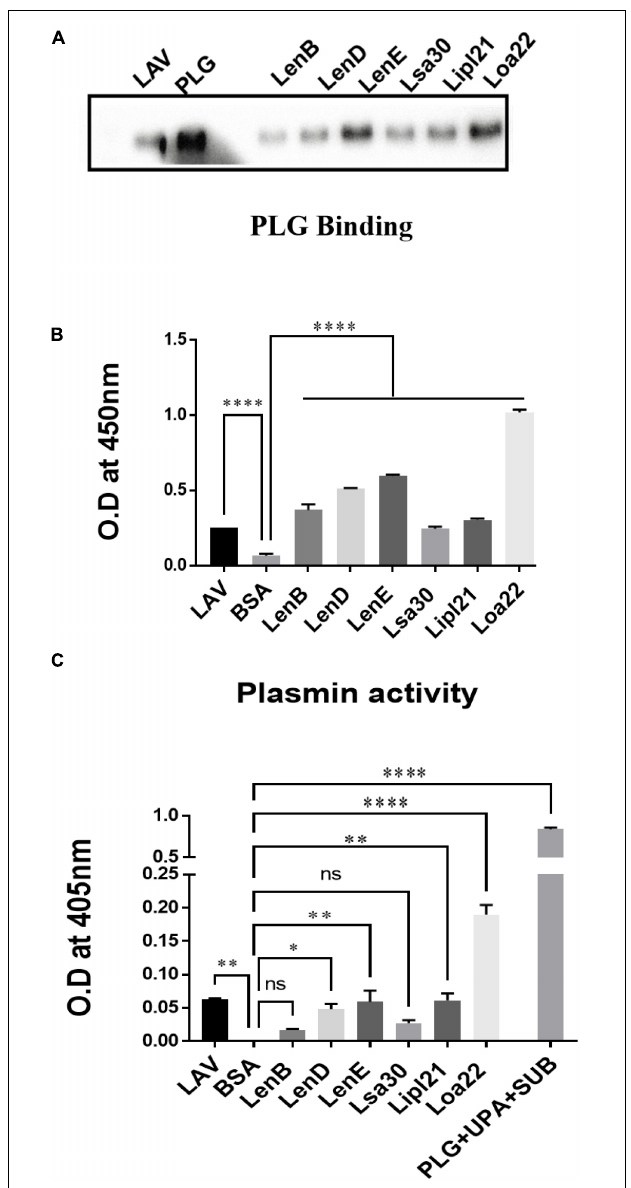
FIGURE 5 | Evaluation of binding of surface proteins with host protease Plasminogen (PLG). (A) Binding of surface proteins with Plasminogen (PLG) as analyzed by pull-down assay. Bead bound proteins (rLenB, rLenD, rLenE, rLsa30, rLipl21, rLoa22, or rLAV; 1 µ g each) or only beads were incubated with 10% HI-NHS (as a source of PLG), and protein–protein interaction was detected by western blot using anti-PLG antibody as described in section “Materials and Methods.”. (B) Binding of surface proteins analyzed by ELISA. Microtiter plates were coated with proteins (1 µ g/ml) or BSA, and binding was detected with anti-PLG antibody as described in section “Materials and Methods”. (C) Plasmin activity. Surface proteins (2 µ g per well) or BSA or LAV (2 µ g per well) were immobilized on microtiter plates followed by the addition of PLG, uPA, and specific plasmin substrate. The plate was incubated overnight, and absorbance was read at 405 nm as described in section “Materials and Methods”. All data are representative of three different experiments. Significant differences were calculated using the one-way ANOVA ( ∗∗∗∗ , ∗∗ , ∗ , and ns indicates P < 0.0001, P < 0.01, P < 0.05, and non-significant,